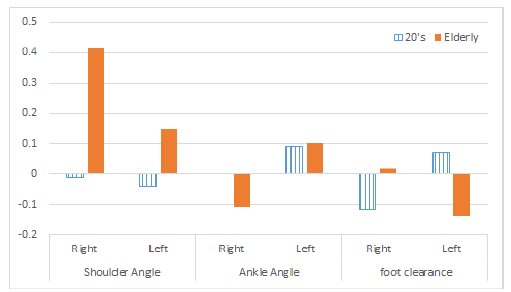
Figure 11. Balance factor.